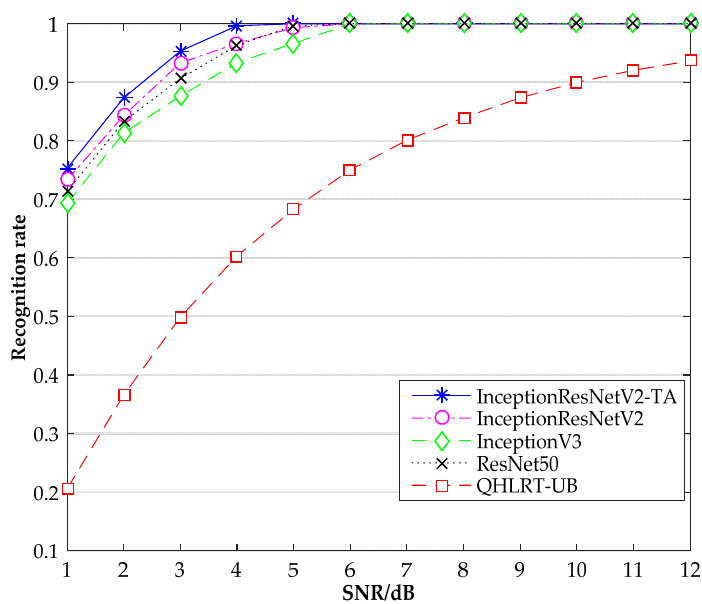
Figure 6. Recognition rate comparison of BPSK by different methods.